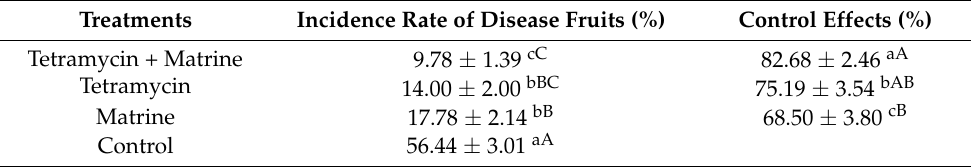
Table 4. The control effects of tetramycin and matrine on soft rot diseases of